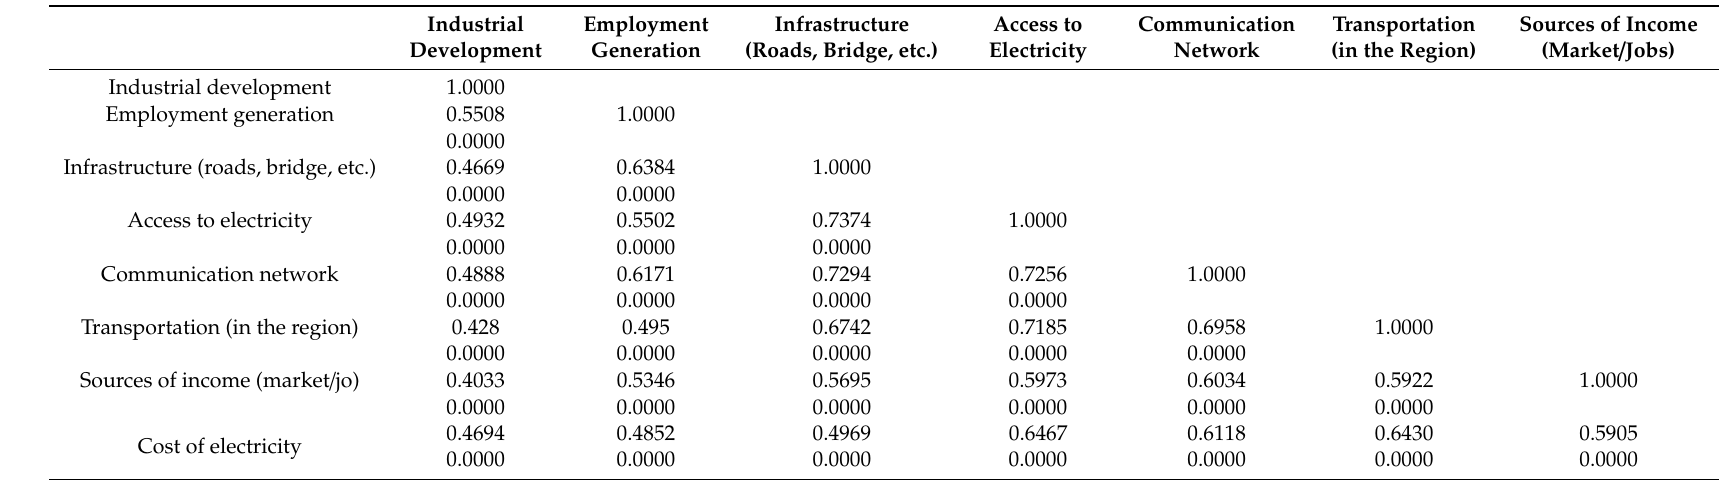
Table 8. Correlation among non-agricultural economic